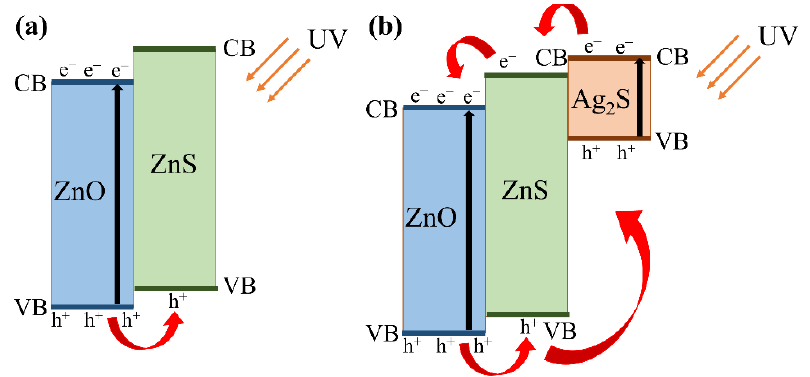
Figure 8. Energy band schematic diagrams of different nanocomposites: ( a ) ZnS/ZnO; ( b ) Ag 2 S/ZnS/ZnO.